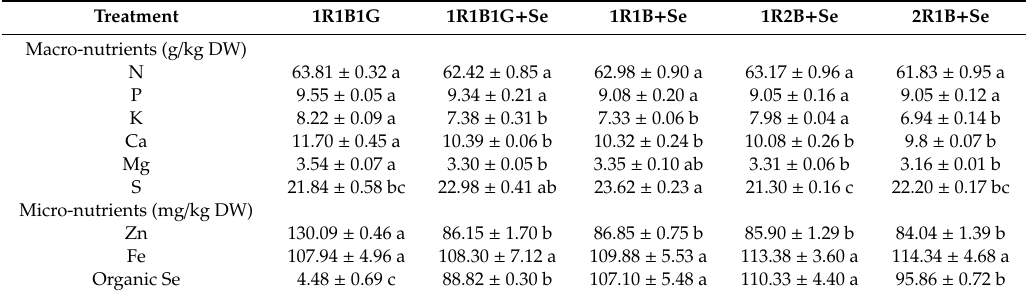
Table 3. The content of mineral elements of broccoli sprouts grown under a combination of selenium and LED light quality treatments.